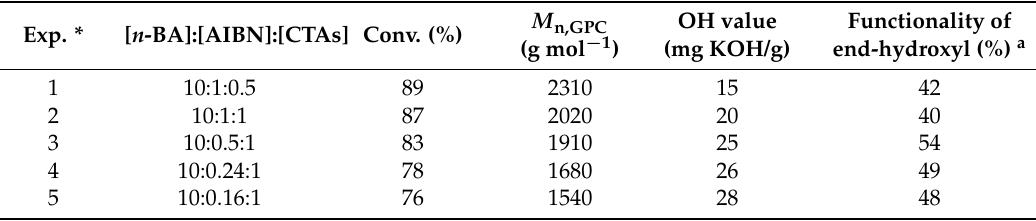
Table 1. Degenerative iodine transfer polymerization (DITP) condition and results of n -butyl acrylate ( n -BA) using diiodoxylene (DIX) and 2,2 (cid:48) -azobis(isobutyronitrile) (AIBN) as transfer agent and initiator, respectively.